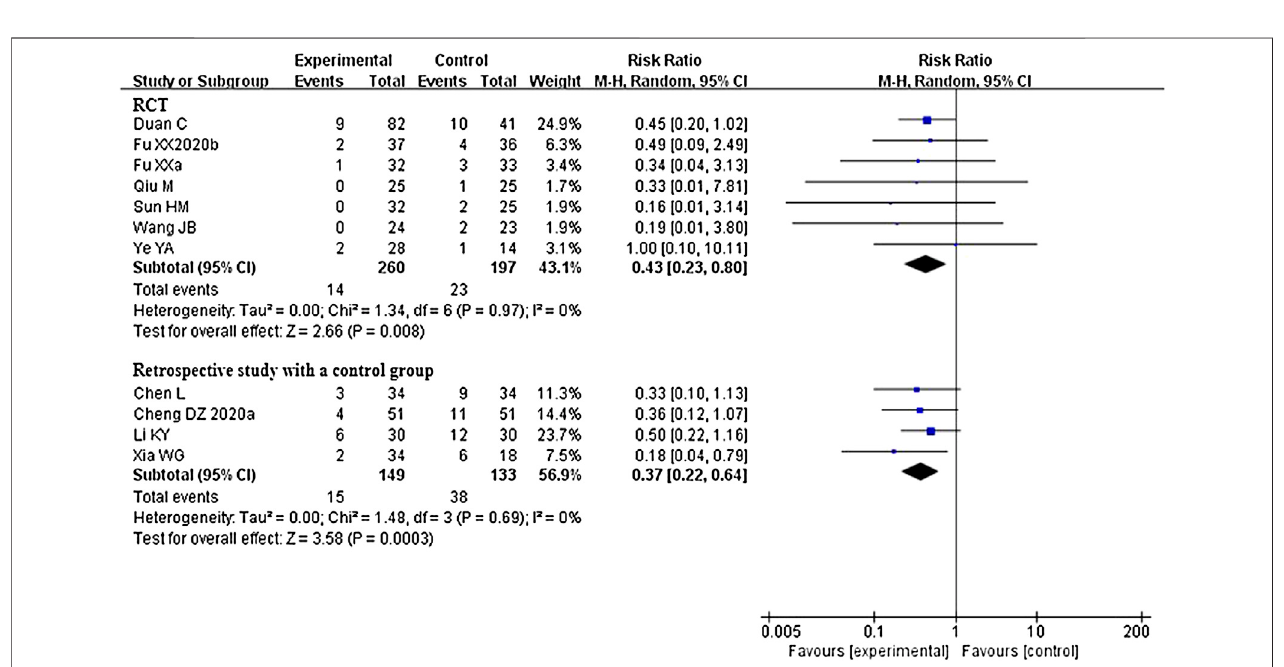
FIGURE 5 | Forest plot of aggravation rate: CHM plus conventional western therapy vs. conventional western therapy.